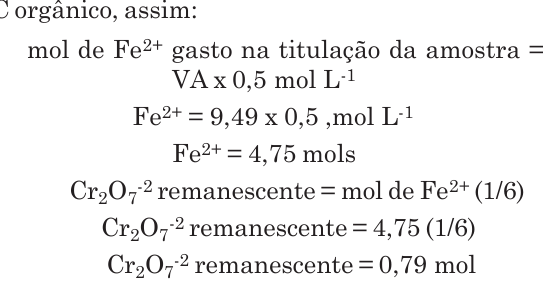
Figura 2. Conteúdo de C na fração pesada da matéria orgânica do solo (g kg -1 de FP) extraída com água destilada ou com iodeto de Na e determinado em analisador elementar (CHN) ou pelo método proposto por Yeomans & Bremner, 1988 (Y & B). Letras iguais para cada solo com o mesmo teor de argila não se diferem quanto aos teores de carbono, ao nível de 5 % pelo teste de Tukey.